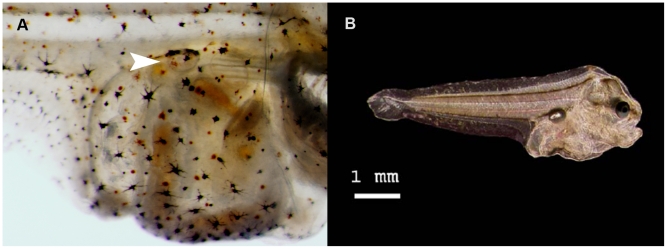
The swim bladder in common sole (Solea solea) larvae.The swim bladder in a stage 4a larva as observed in this study (A) and a published image [36] of the swim bladder in a stage 4a larva (B).